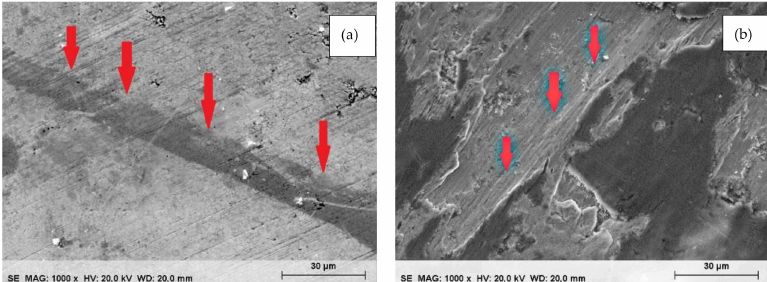
Figure 7. SEM images of worn tracks from ball-on-disk testing. ( a ) WC-12Co, with arrows indicating the wear track. ( b ) 316L bulk, with the arrows indicating furrows in the direction of ball moving.